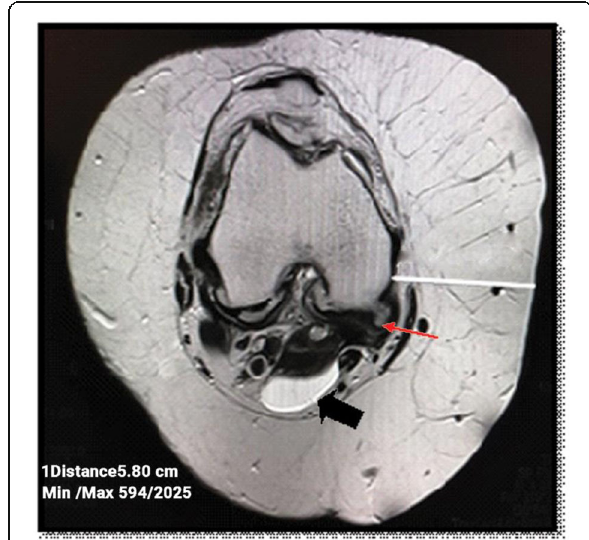
Fig. 5 Measurement of the subcutaneous fat thickness. Axial T2WI of the knee showing subcutaneous fat measurement on the medial aspect of the knee joint behind the medial femoral condyle. Osteophite (red arrow), backer cyst (bold arrow)